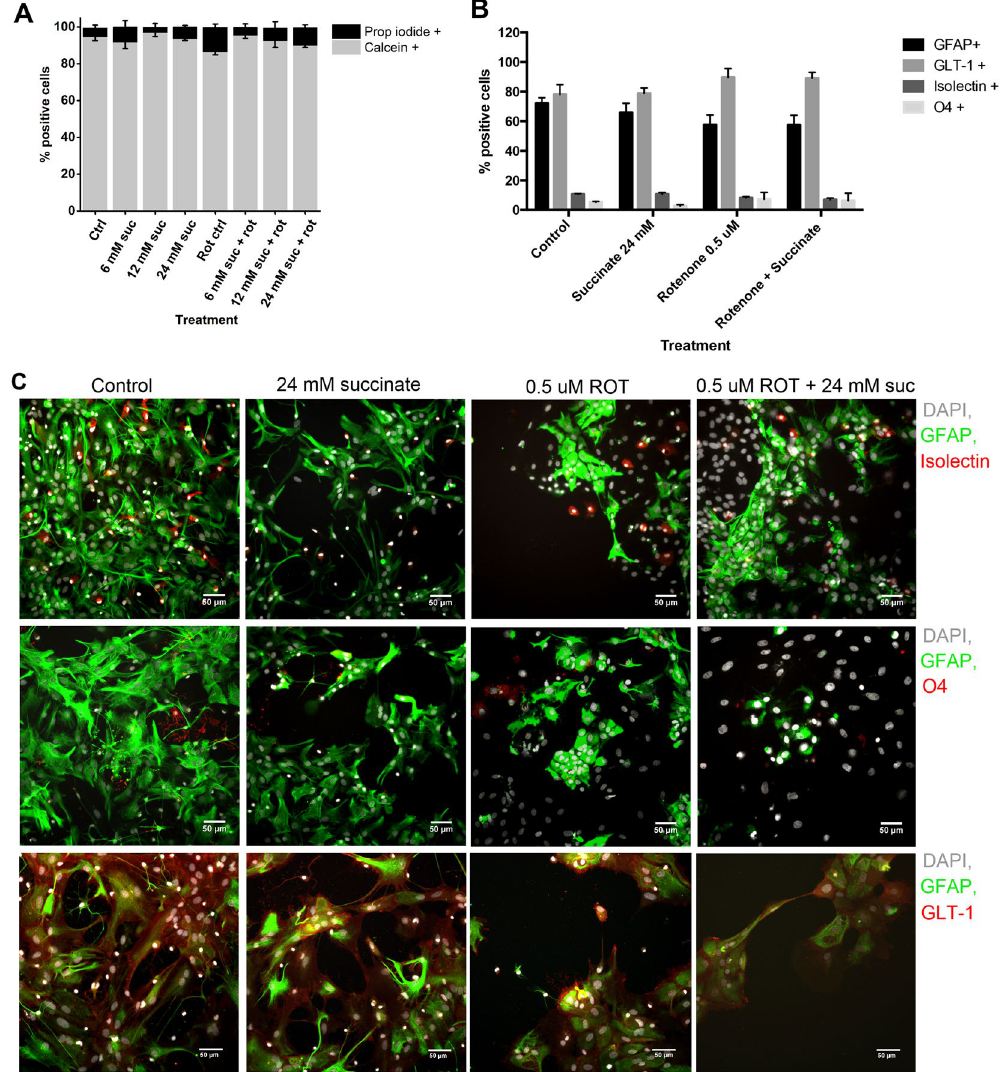
Figure 4. Effect of rotenone and succinate on cell viability and expression of cellular markers. ( A ) Percent of total cells stained with propidium iodide (dead cells) and calcein (viable cells) after 24 h of treatment with succinate and/or 0.5 µ M rotenone v. control conditions. ( B ) Percent of total cells expressing the different cellular markers (GFAP, GLT-1, isolectin and O4) after 24 h of succinate treatment, with or without 0.5 µ M rotenone. All values in A and B are mean ± standard error of the mean (s.e.m.) of > 500 cells analysed (n = 6 individual wells from 2 independent experiments). The expression of cellular markers did not change significantly with rotenone or succinate treatment. ( C ) Images of the mixed glial cells stained with the markers DAPI (grey), GFAP (green), GLT-1 (red), isolectin (red) and O4 (red) after 24 h of succinate treatment, with or without 0.5 µ M